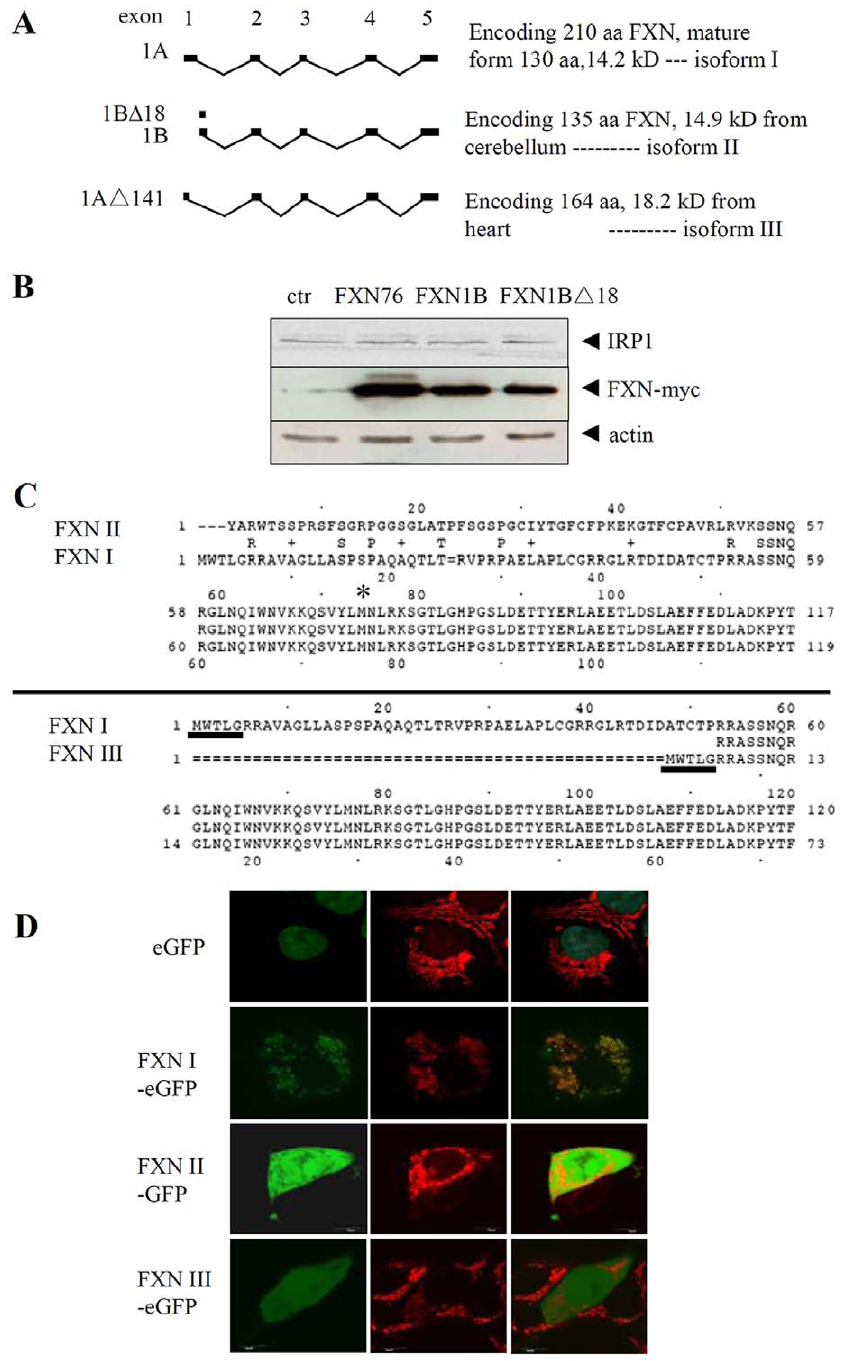
Figure 2. Comparison of putative human FXN isoforms. ( A ) Schematic diagram of the putative FXN isoforms expressed in human heart or cerebellum. ( B ) Western blot showing that exon1B-containing transcript variant encoded a second-AUG initiated isoform FXN76, i.e., FXN II. ( C ) Protein alignment of FXN isoform I, II, III, encoded by transcripts containing canonical exon 1A, exon1B/exon1B g 18, and exon1A g 141, respectively. Hereafter, exon1B replaces exon1B/exon1B g 18. This figure only shows the N-termini of FXN. In the upper panel methionine in the middle of the sequence of FXN is marked with an asterisk, which may be the start codon of the novel FXN transcript containing exon 1B. Underlined amino acid sequences in the bottom panel are identical between the isoform I and III. ( D ) Cellular localization of different isoforms of human FXN. eGFP only: in nucleus; FXN I-eGFP: in mitochondria; FXN II-eGFP: in cytosol and nucleus; FXN III-eGFP: more in nucleus than in cytosol.